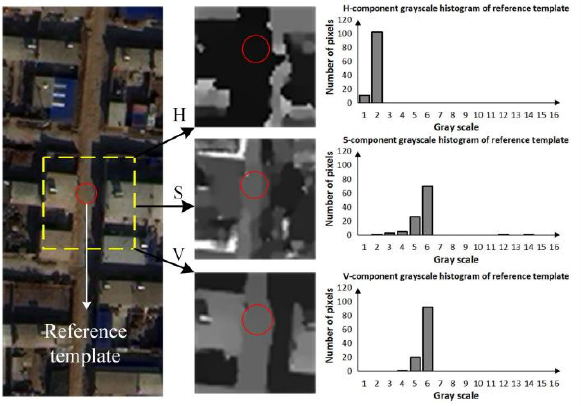
Figure 11. Each component the reference grayscale histogram template.